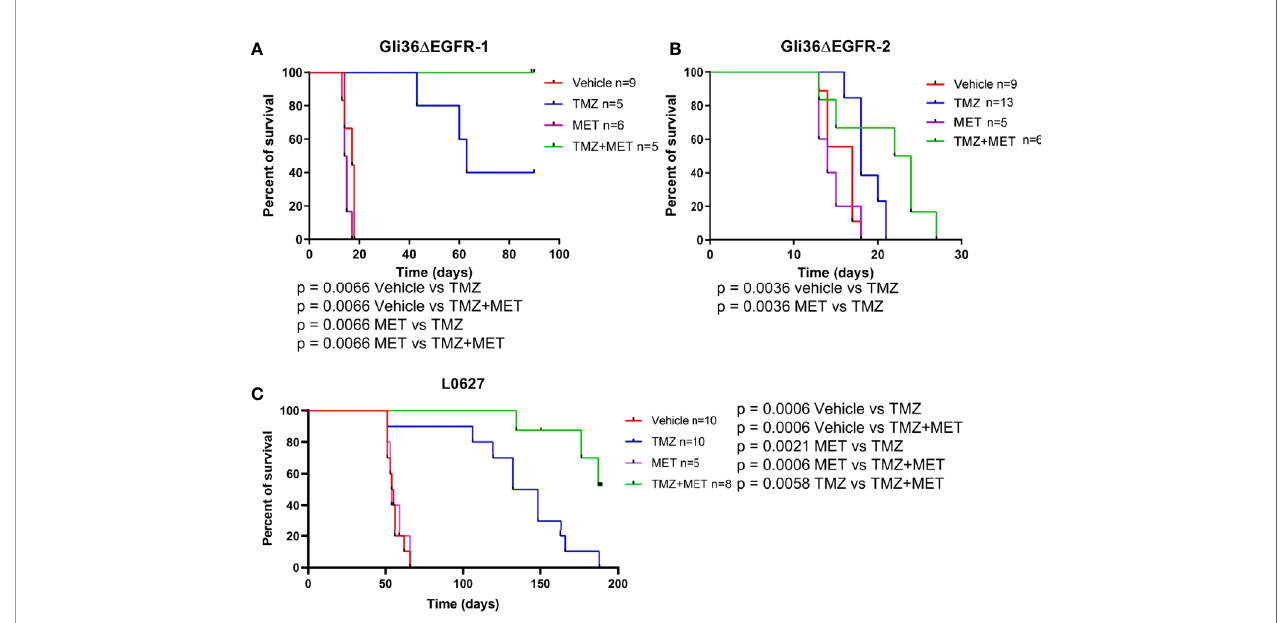
FIGURE 2 | Survival curves of GBM-bearing mice. (A – C) , nude mice were injected with Gli36 D EGFR-1, Gli36 D EGFR-2 or L0627 cells. At tumor onset, mice were grouped by different treatments and treated with vehicle, TMZ, MET or TMZ+MET (n = 13-5/group as indicated). Log-rank Mantel-Cox test was performed for survival comparison followed by Holm-Sidak method for multiple comparisons correction. MET, metformin; TMZ,